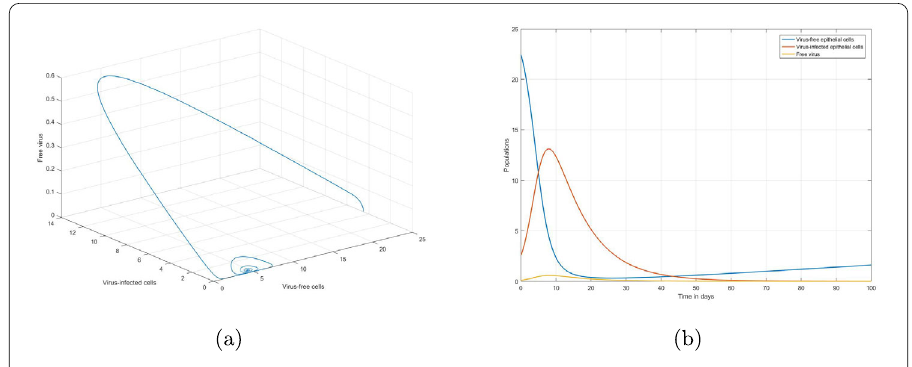
Figure 1 Dynamics of the numbers of virus-free epithelial cells, virus-infected epithelial cells, and SARS-CoV-2 virus when χ 0 >